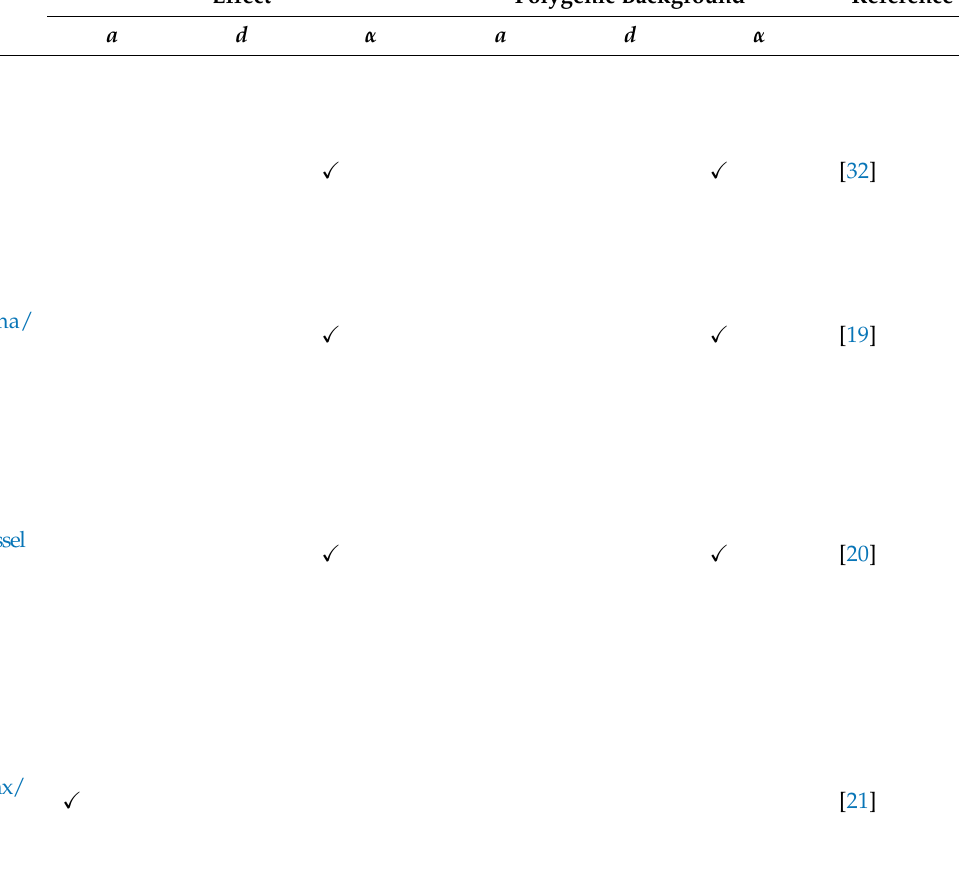
Table 1. Single-locus model and their respective software and packages for GWAS using LMM.